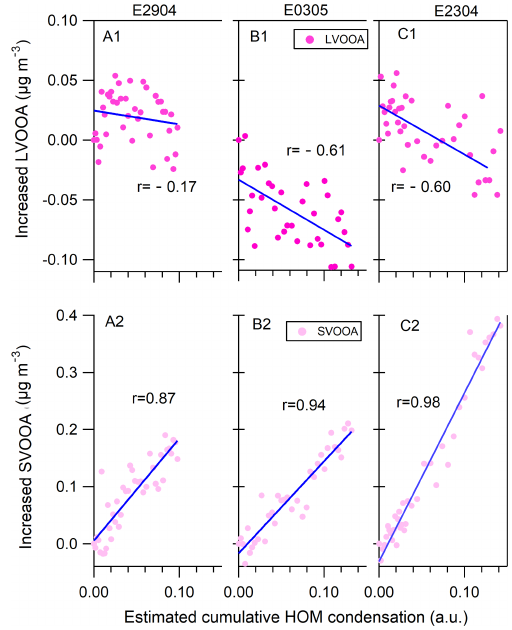
Figure 5. Comparisons of the increased mass of LVOOA (a1–c1) and SVOOA (a2–c2) in measurements (vertical axis) to the esti- mated accumulated amount of HOMs condensed onto the particle phase (horizontal axis) at the particle growth stage (gray bars in Fig. 2). Note that AMS did not work in the E0904 growth period (event day of 9 April 2014) and thus the results are not